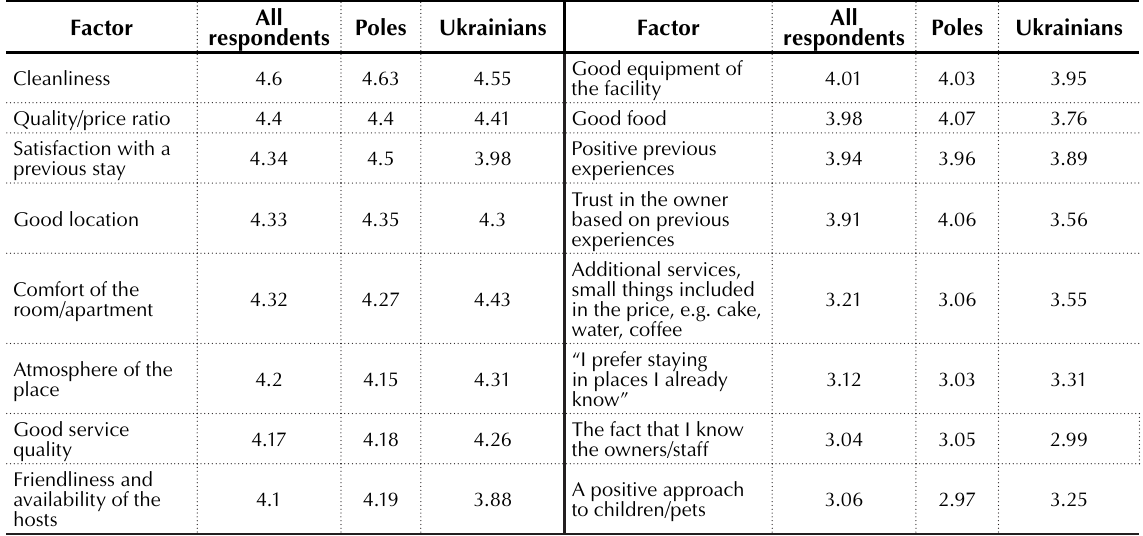
Source: Own work based on the survey